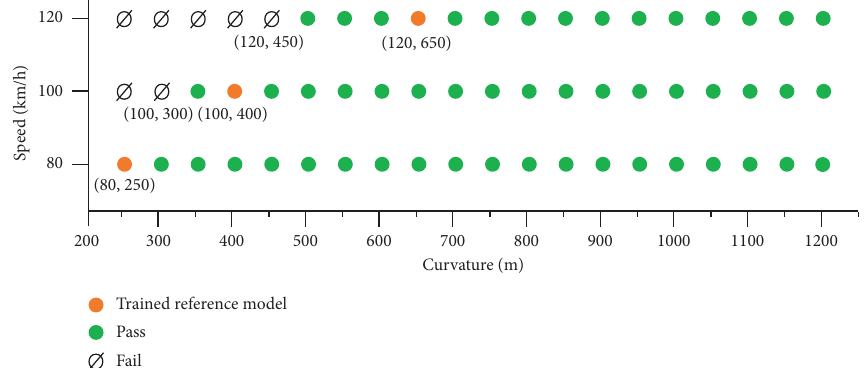
Figure 12: Simulated unintended lateral attack in 3 scenarios: 120km/h, 100km/h, and